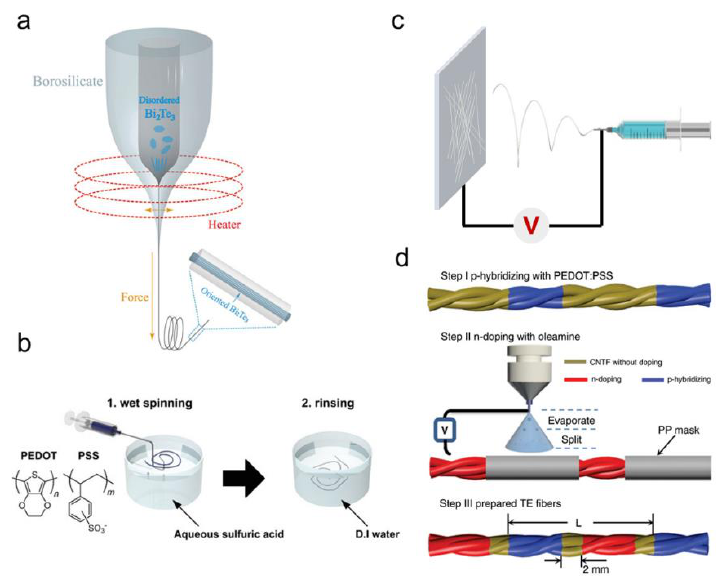
Figure 2. Fabrication methods for thermoelectric fibers. ( a ) Thermal co-drawing. Reproduced with permission from Ref. [41]. Copyright © 2018, AIP Publishing. ( b ) Wet spinning. Reproduced with permission from Ref. [42]. Copyright © 2020, Wiley-VCH. ( c ) Electrospinning. ( d ) Coating. Reproduced with permission from Ref. [43]. Copyright © 2020, Springer Nature.